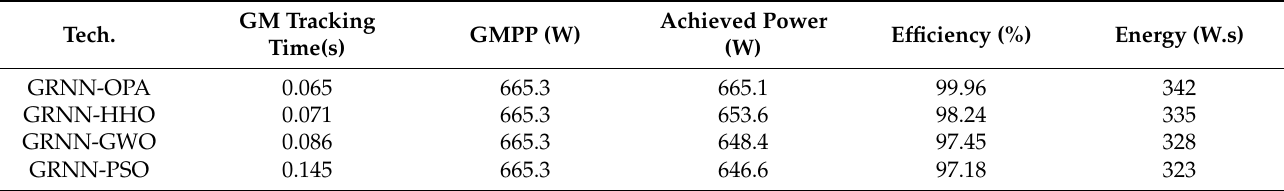
Figure 9. Comparison of energy extracted in case 1. Table 1. Comparison of results for case 1.